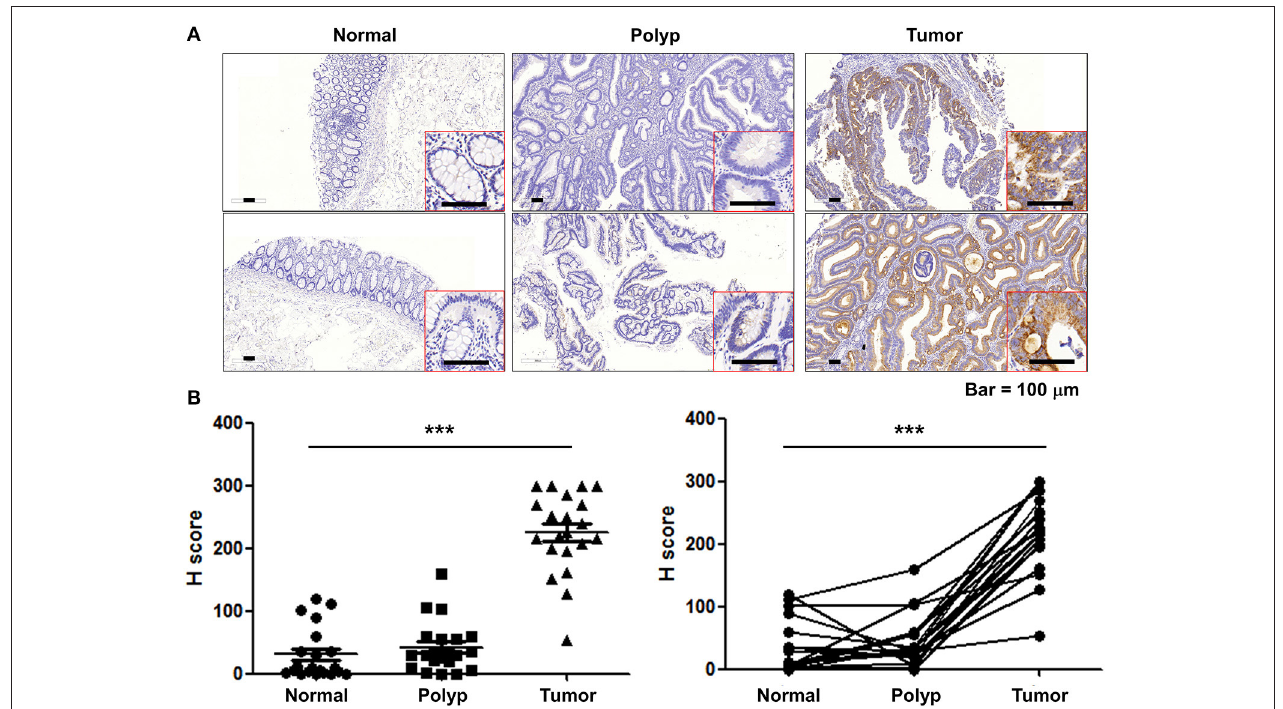
FIGURE 1 | KMO are upregulated in CRC tumor tissues. (A) Representative images for KMO expressions in CRC tumor, paired polyps, and paired normal counterparts’ specimens were detected by immunohistochemistry. Scar bar, 100 µ m. (B) Scatter dot plots for H-score of KMO staining ( N = 21). Student’s t -test, *** P <